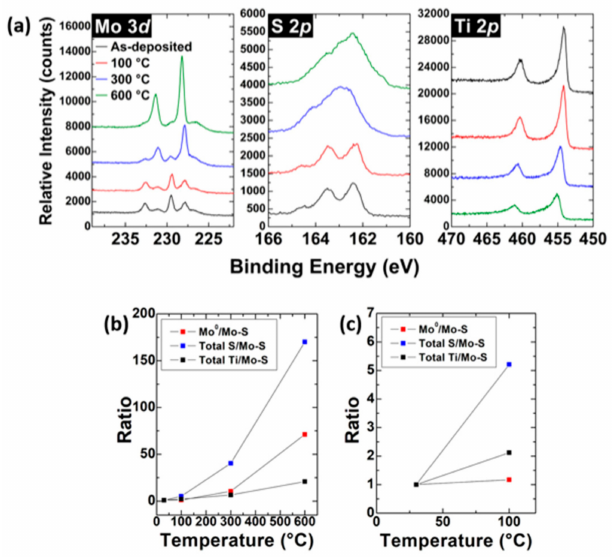
Figure 6. ( a ) XPS spectra acquired following 30 min anneals at each temperature. These were performed sequentially on the same sample. ( b ) Intensity ratios based on the data in ( a ) where ( c ) highlights the changes that occur at 100 ◦ C. Reprinted with permission from Freedy et al. ACS Appl. Mater. Inter. 11(38) 35389, (2019). Copyright (2019) American Chemical